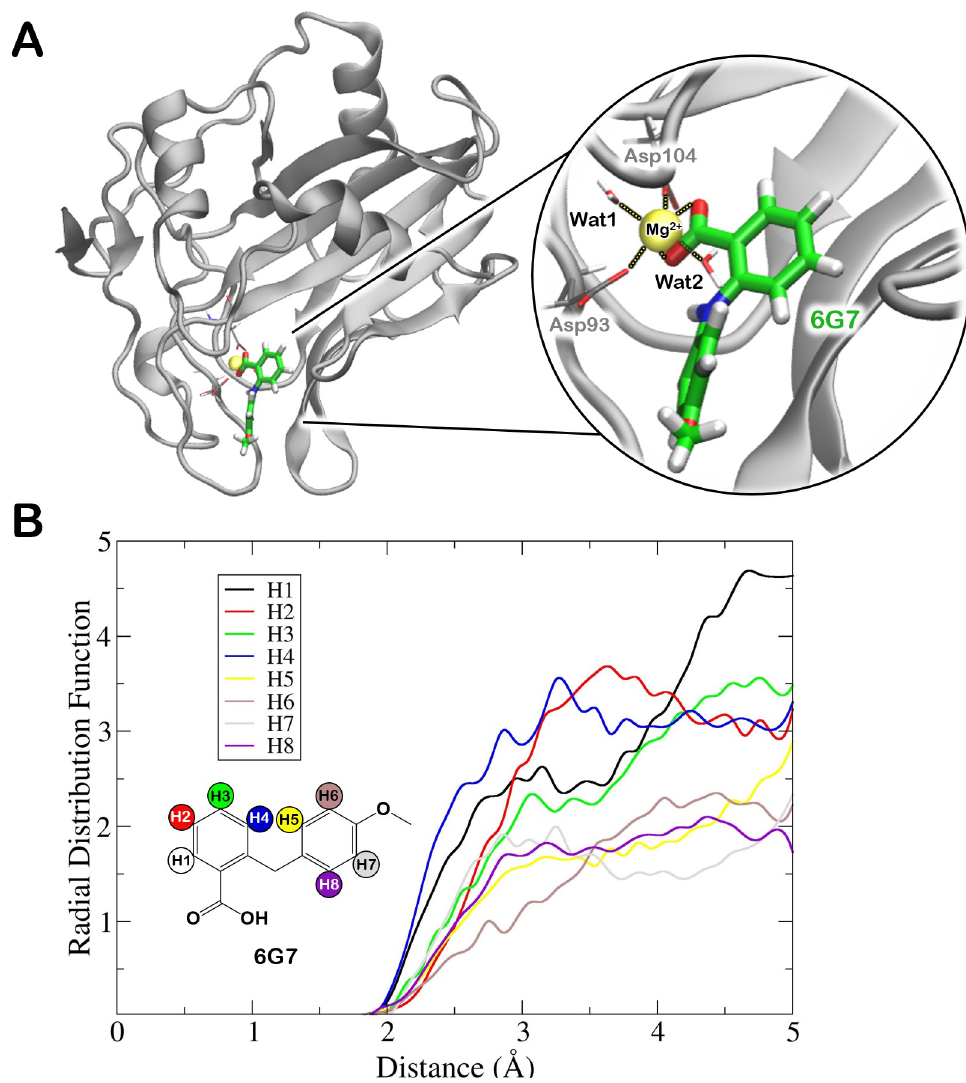
Fig 5. Inhibitor’s binding pose prediction. (A) Complex of NLP Pya with the 6G7 ligand and inset of 6G7 binding mode, as obtained after ~5 ps of quantum/classical (QM/MM) simulations. The 6G7 carboxyl group bound to Mg 2+ ion, whose octahedral coordination sphere is completed by three water molecules, and by the NLP Pya residues Asp93 and Asp104. The protein is represented as gray cartoons, the Mg 2+ ion as a yellow van deer Waals sphere, while the residues completing the Mg 2+ coordination sphere and the ligand are shown in licorice with carbon, oxygen, nitrogen and hydrogen atoms depicted in gray (for protein), green (for inhibitor), red, blue and white, respectively. (B) Radial distribution function plotting the probability density of finding a NLP Pya protein hydrogen atoms at r distance ( Å ) from any hydrogen atoms of 6G7 .